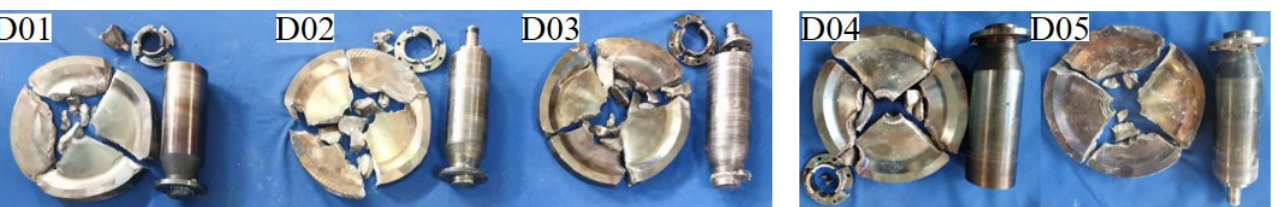
Figure 13. Discs after fatigue failure (D01–D05 are arranged from left to right).